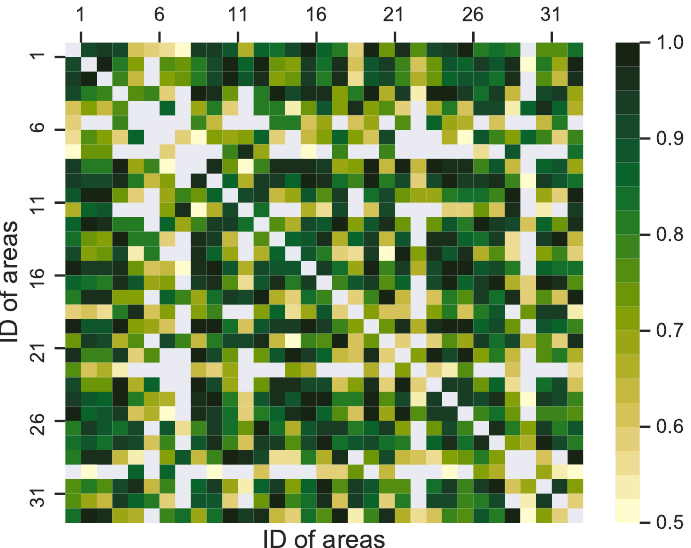
Figure 5. The heat map of the visualization of the weighted matrix W , which is determined by the distance between the two areas. The color of the heat map indicates the weight values of the two parking areas, which can be calculated by using Equation (2).